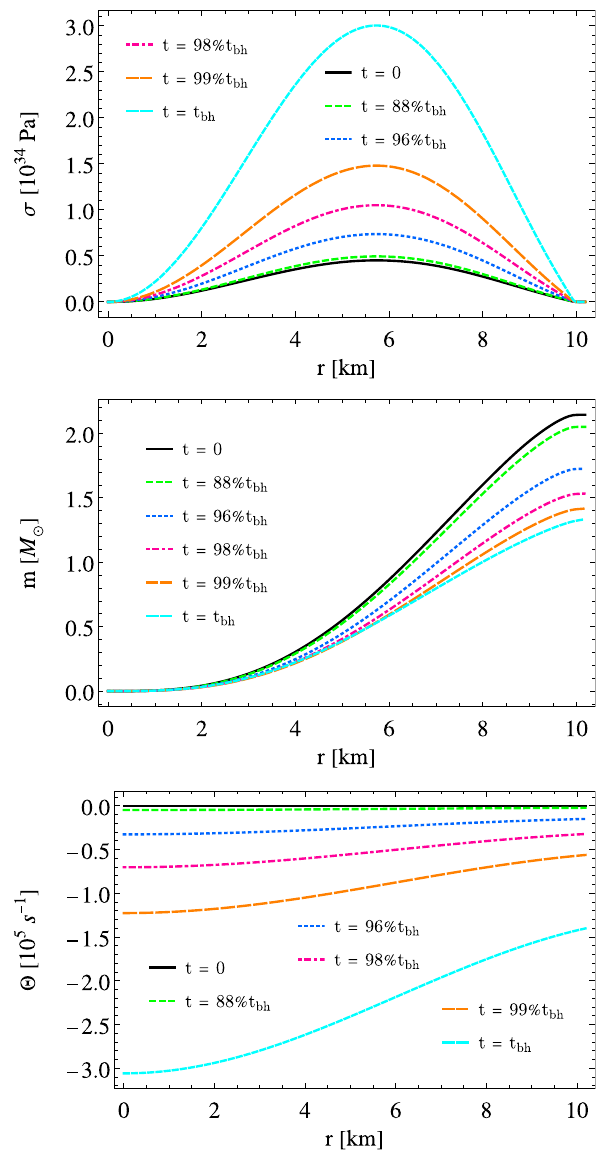
Fig. 7 Radial profile of the anisotropy ansatz (upper panel) described by Eq. (66), mass function (intermediate panel) given by (46), and expansion scalar (lower panel) during the collapse process at differ- ent instants of time. The results are for the same solution as in